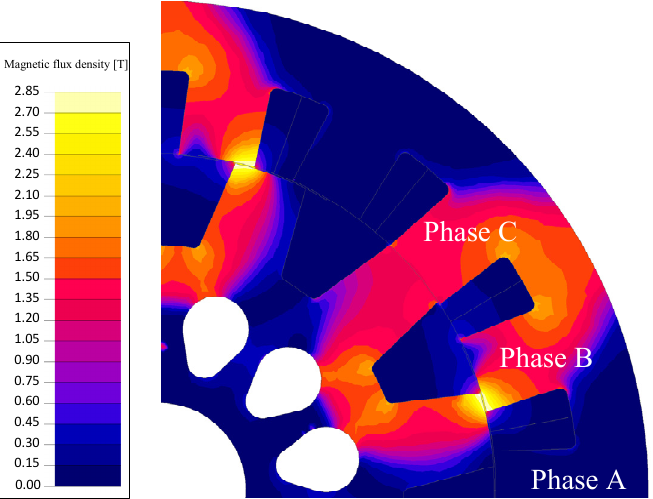
Figure 17. Magnetic flux density distribution in the dynamic model of 18/12 LSA SRM.